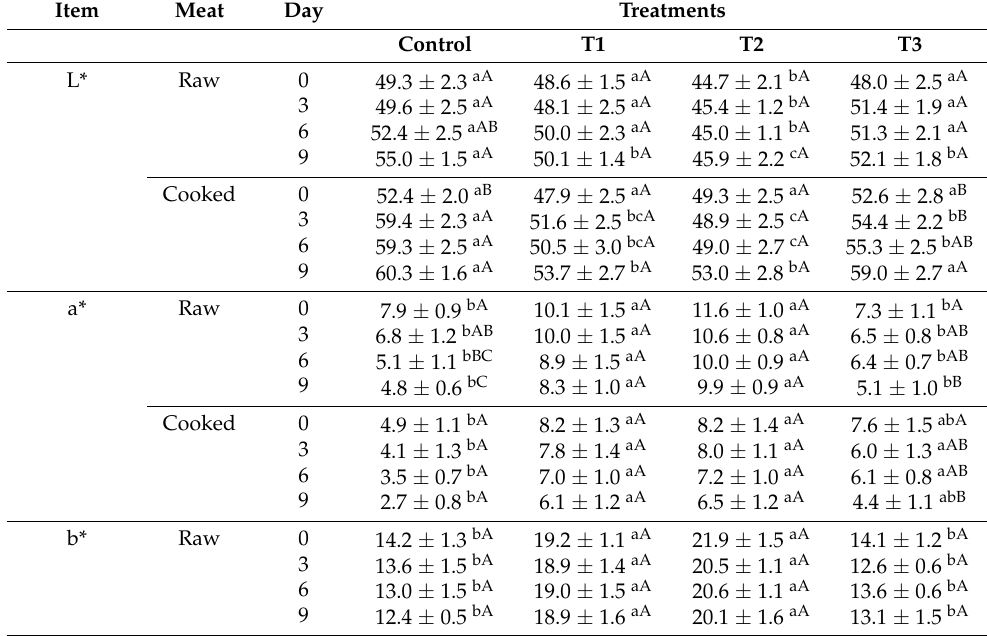
Table 4. Instrumental color during storage of raw and cooked pork